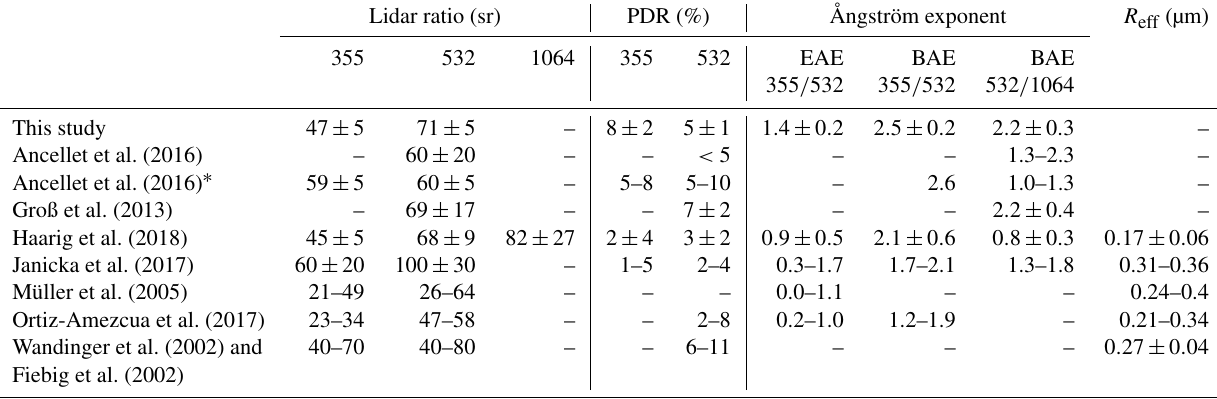
Table 1. Optical properties (lidar ratio; particle linear depolarization ratios – PDRs; backscatter- or extinction-related Ångström exponent – BAE or EAE) of biomass burning aerosols. Layer-mean values of the SPoI (smoke plume of interest) and the standard deviations are given. Optical properties and the effective radius ( R eff ) found in the literature on aged forest fire smoke aerosols observed in the troposphere are also given for comparisons. The source regions of these smoke aerosols are all Canada and/or North